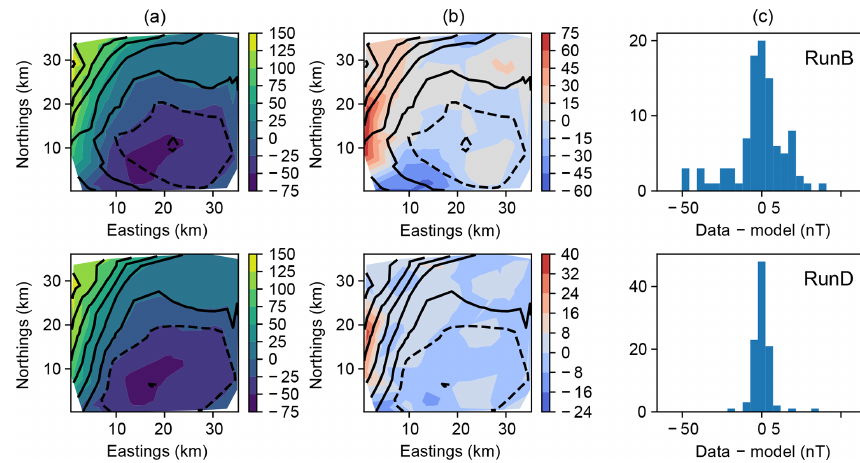
Figure 6. Magnetic anomaly at the surface ( z = 0) in the same format as Fig. 5.